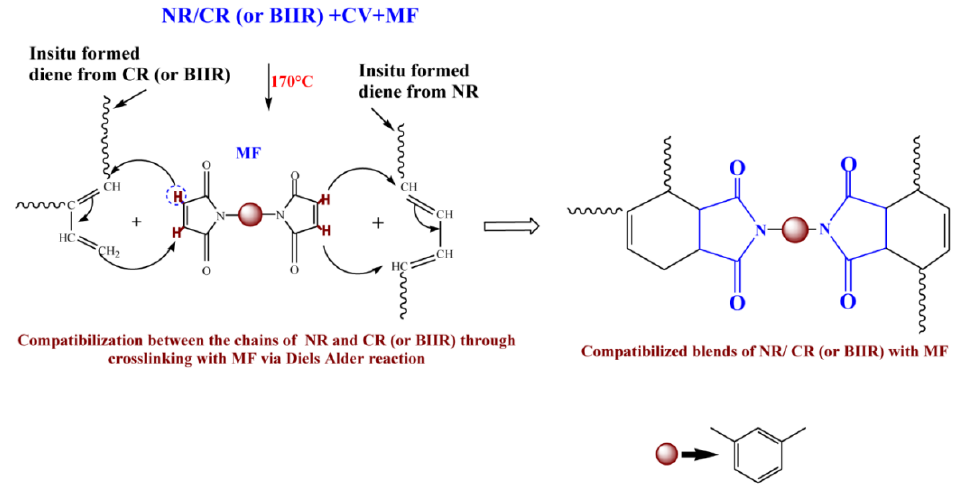
Figure 5. Plausible mechanism proposed for the compatibilisation (co-curing) effect of MF between NR and CR (BIIR) via Diels–Alder